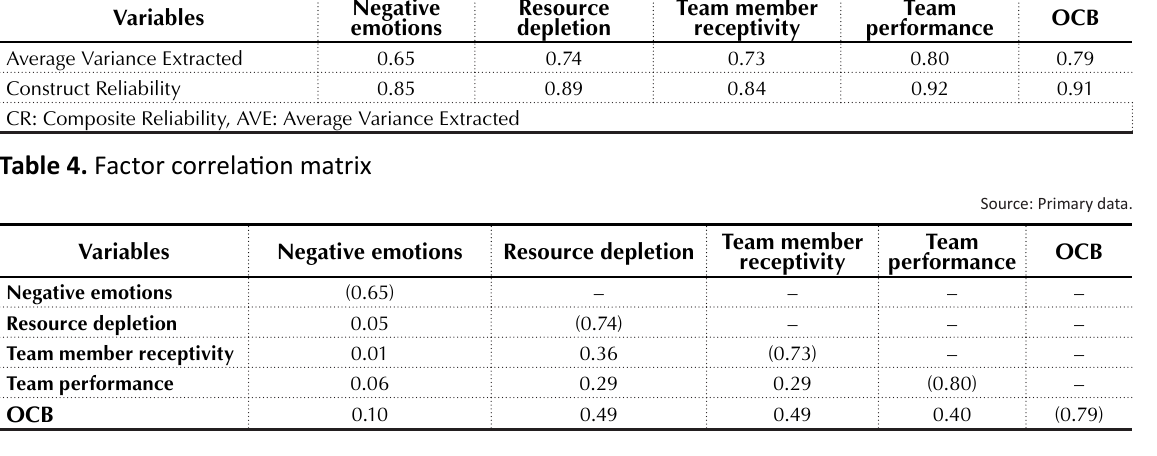
Table 3. The Confirmatory Factor Analysis (CFA) result